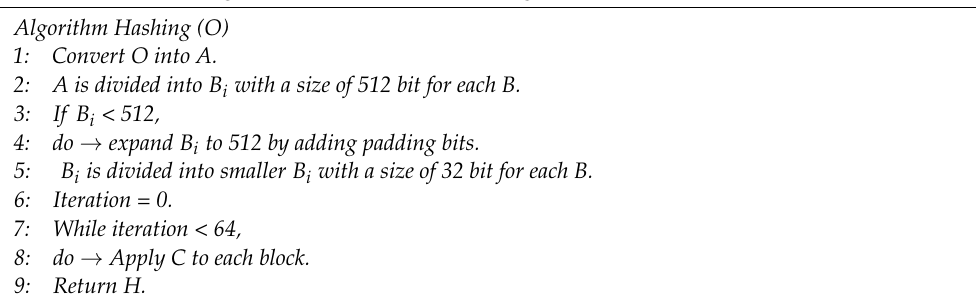
Algorithm 2 . Hashing function of the blockchain algorithm